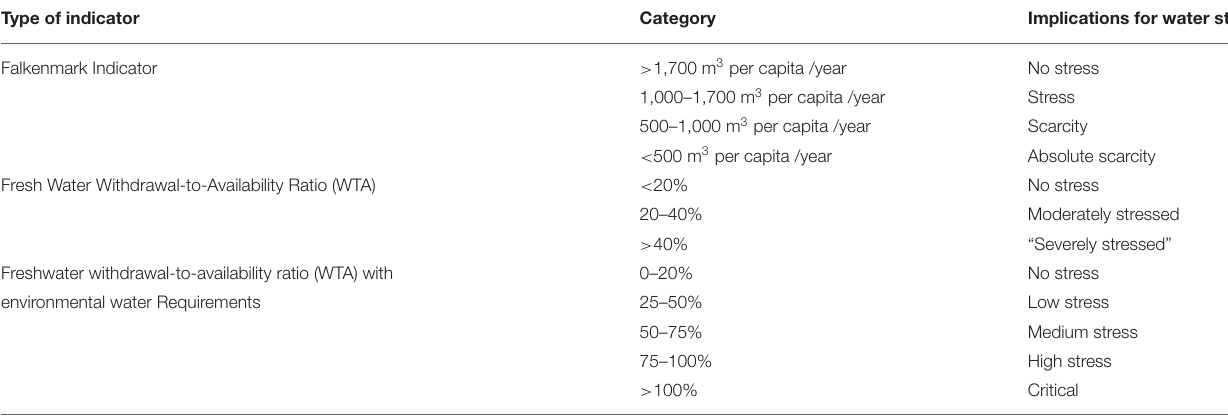
TABLE 1 | Water stress indicators and their